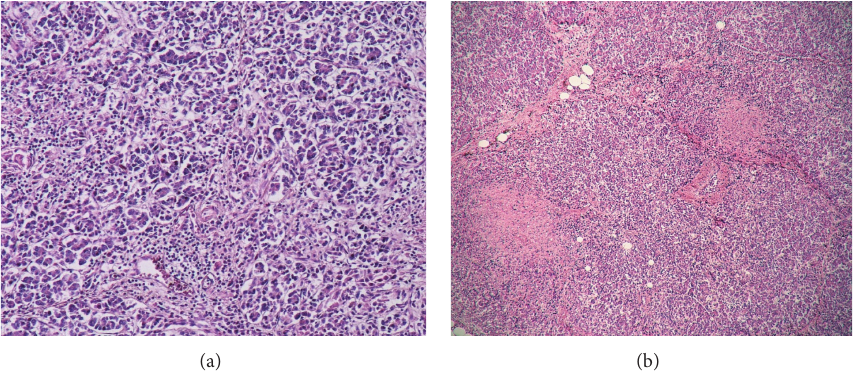
Figure 1: Focal inflammatory infiltrates within the pancreatic parenchyma. Haematoxylin and eosin, × 100 (a). Dispersed granulomas formed predominantly of epithelioid cells. Haematoxylin and eosin, × 40